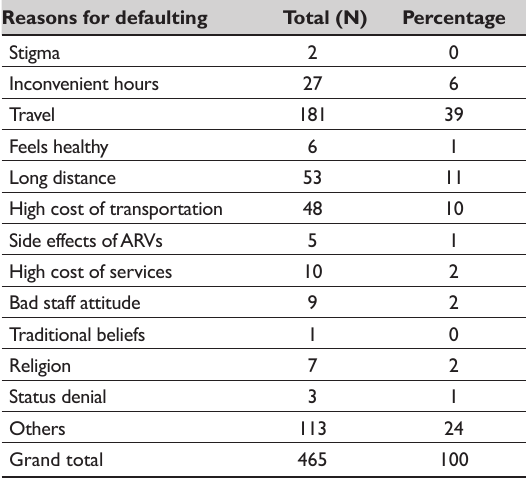
Table 3: Reasons for defaulting on treatment